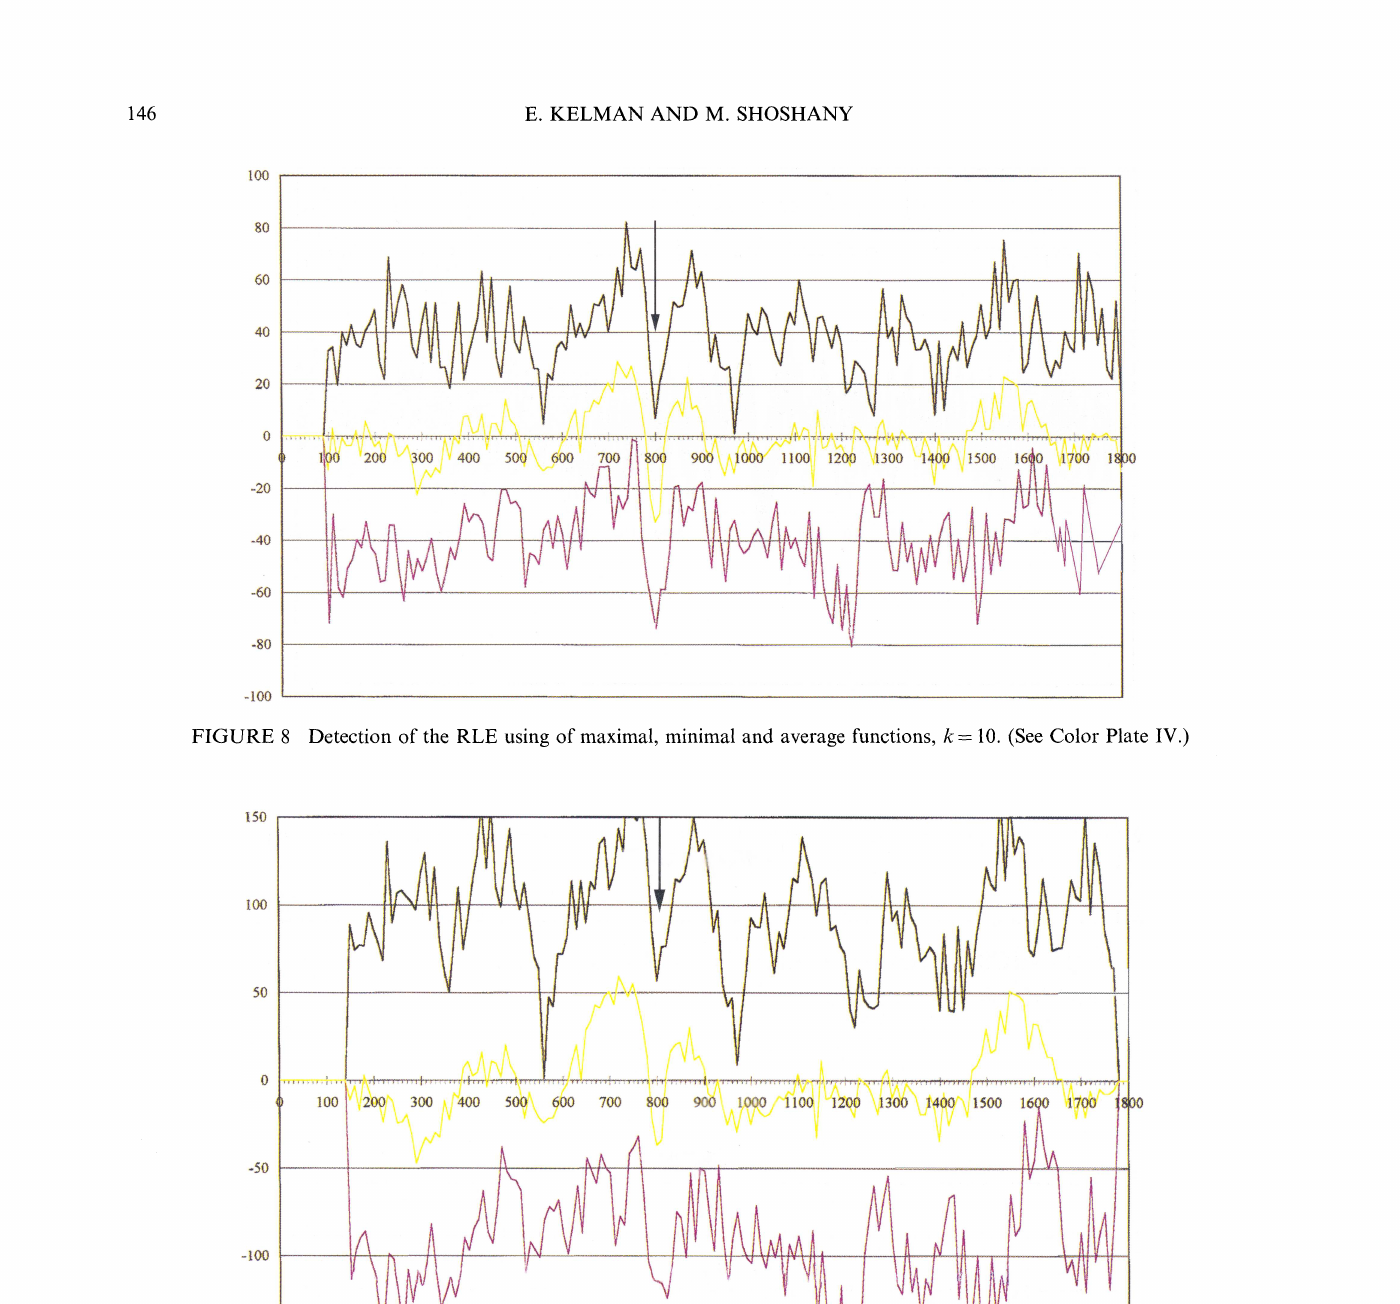
FIGURE 9 Detection of the RLE using of maximal, minimal and average functions, k 15. (See Color Plate